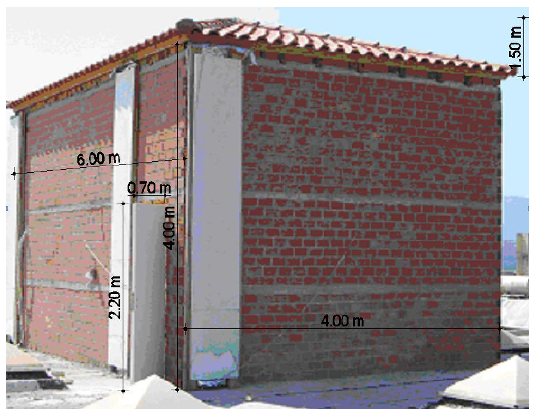
Figure 1. View of the test chamber.